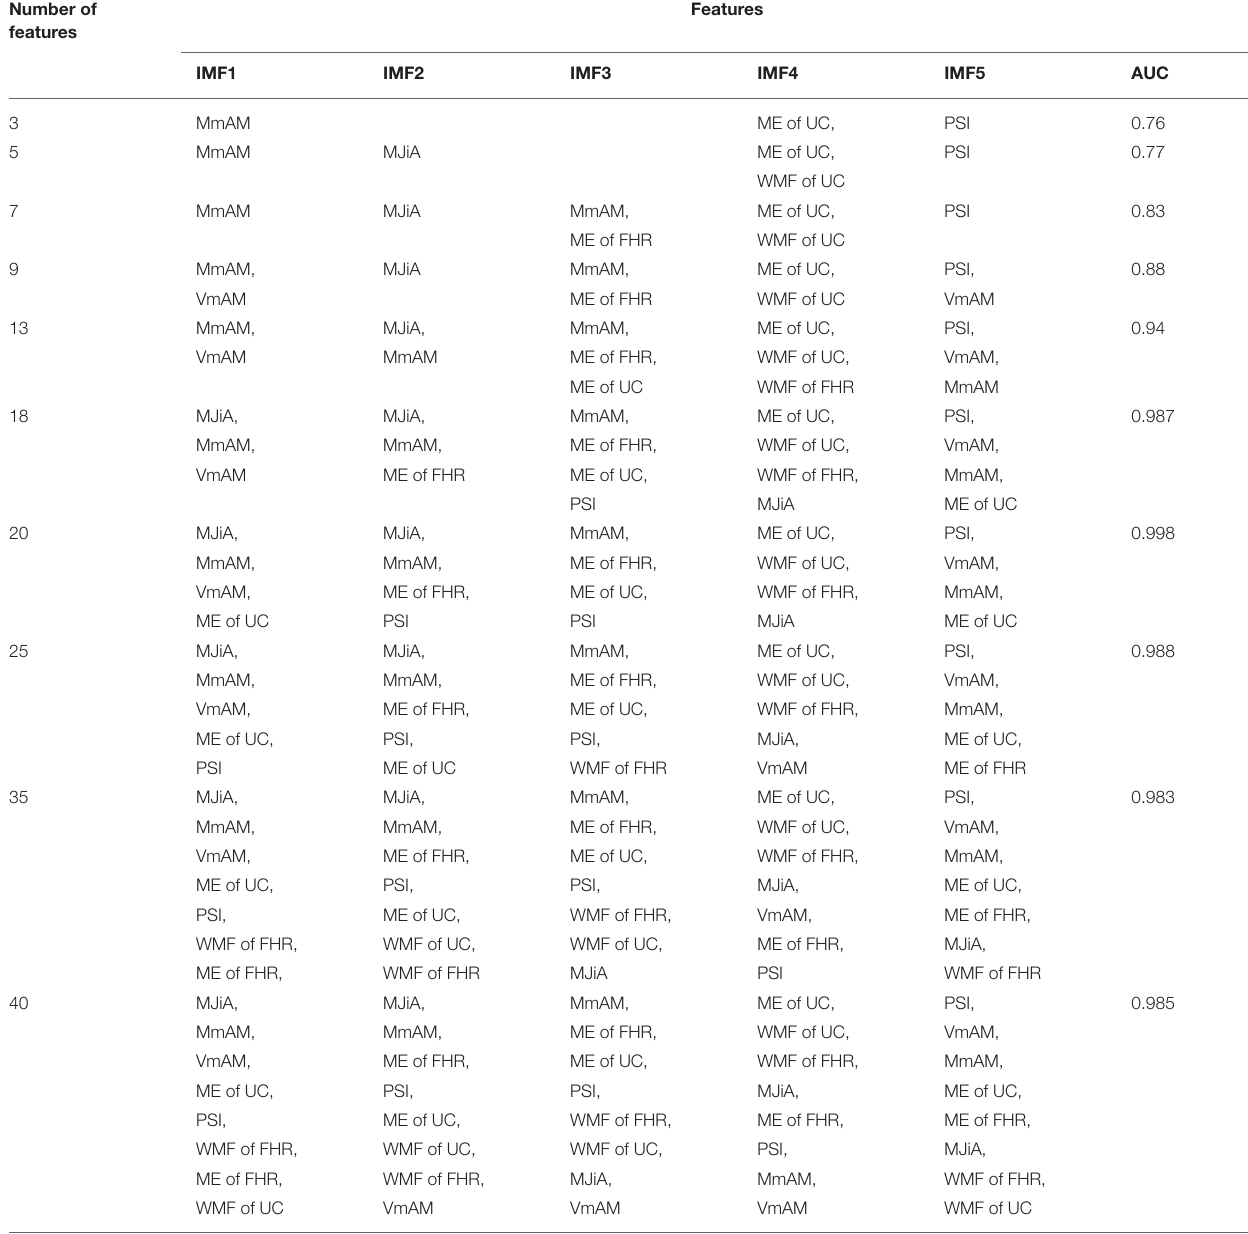
TABLE 2 | Combinations of features corresponding to features’ selection as of Figure 5